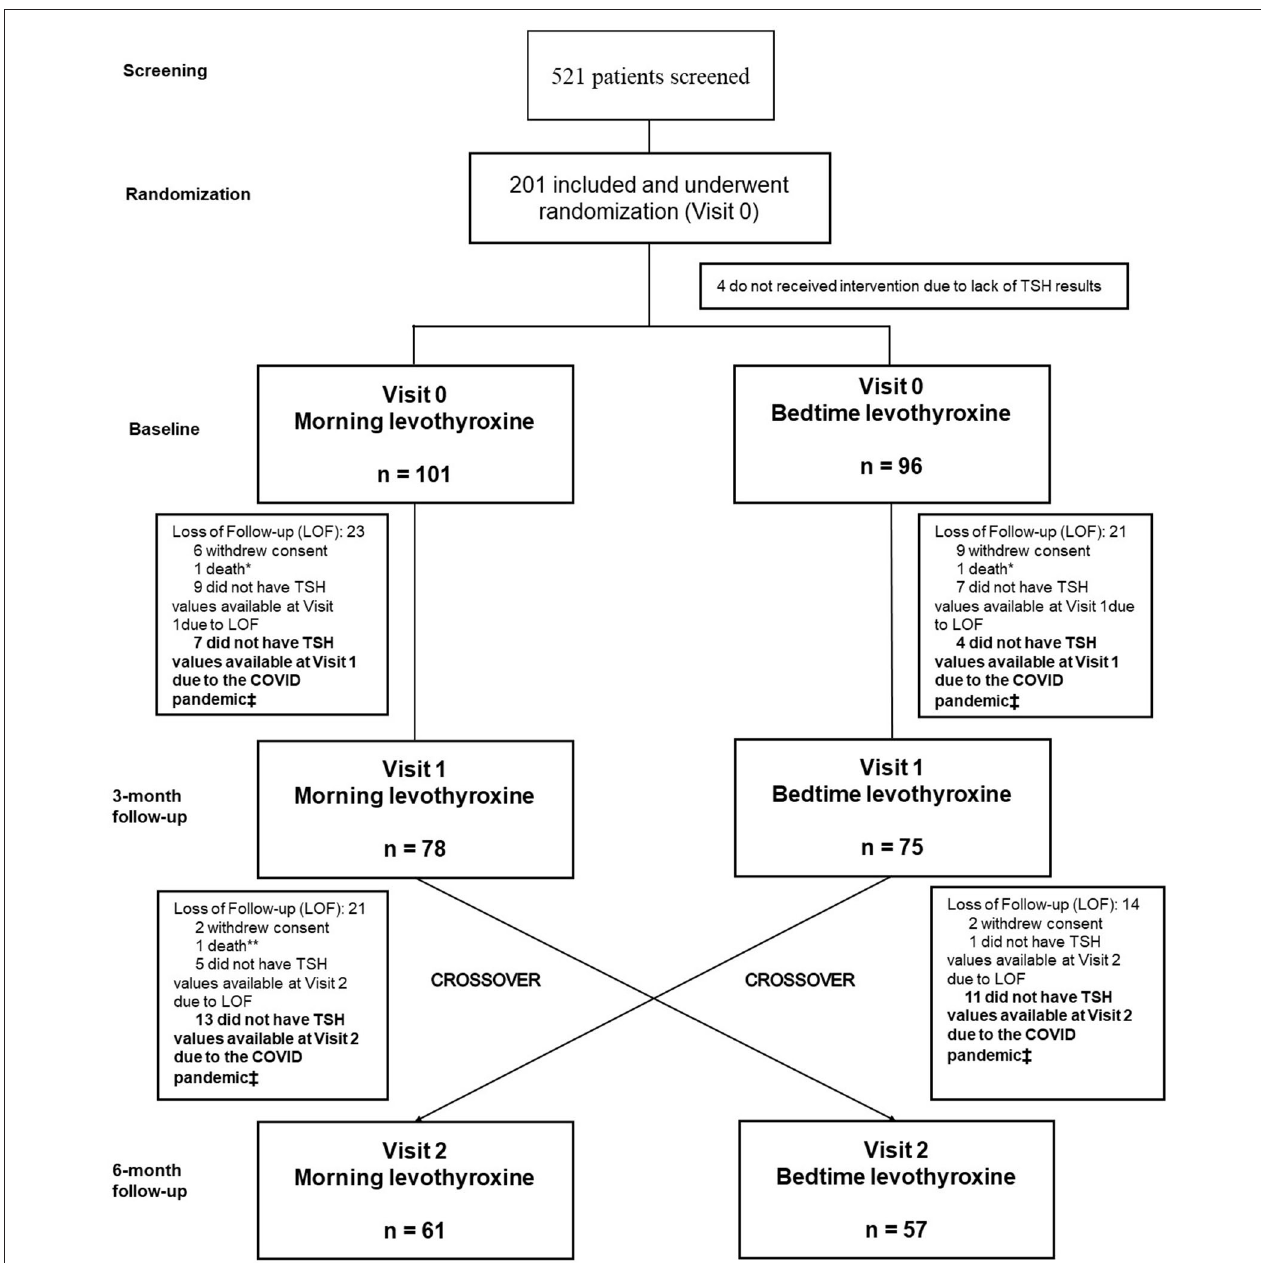
FIGURE 1 | Study design and